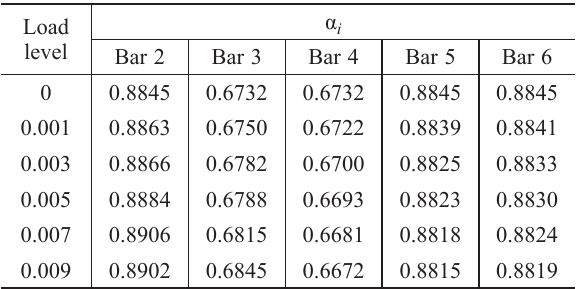
Table 5. Element importance indexes of the planar truss under horizontal load as shown in Figure 5(a)